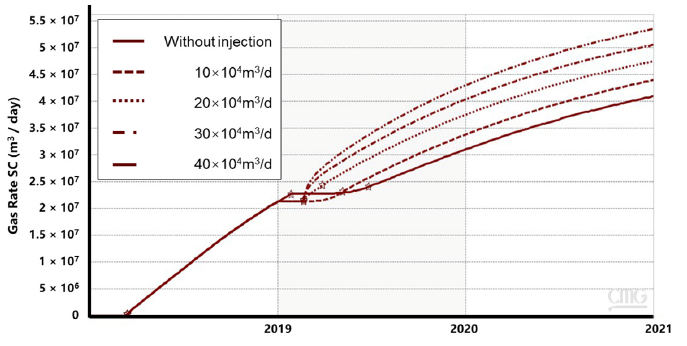
Figure 21. Effect of injection rate of pressurization on cumulative gas production.